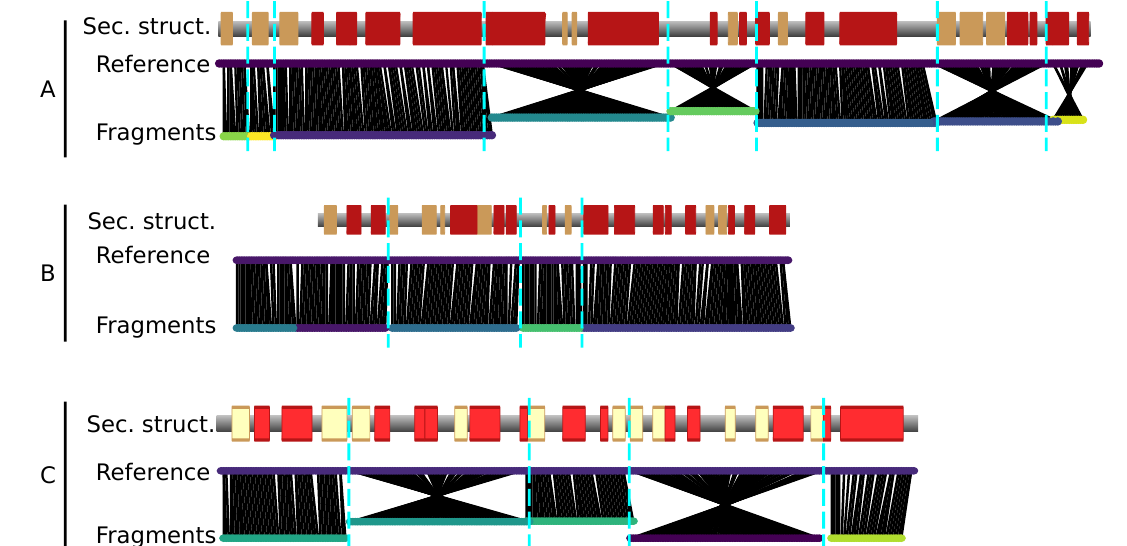
Figure 3. Fragments resulting from the map threading (bottom lines) and aligned on the reference model 4CI0 (upper lines) for the 3 chains ( A – C ). The red and yellow boxes indicate α -helices and β -strands, respectively, in the reference model. The black lines indicate the nearest C α atom in space from the fragment to the reference model. Crossed line bundles indicate fragments that have been reversed with respect to the originally predicted direction of the